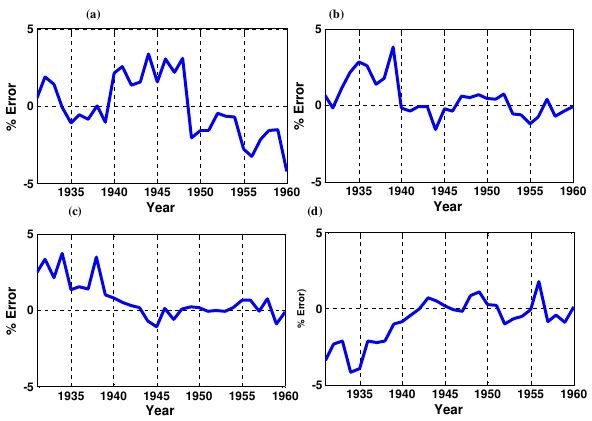
Fig. (16). Error Distribution for (a) July (b) June (c) May (d) March Fig. 16. Error Distribution for (a) July (b) June (c) May (d)